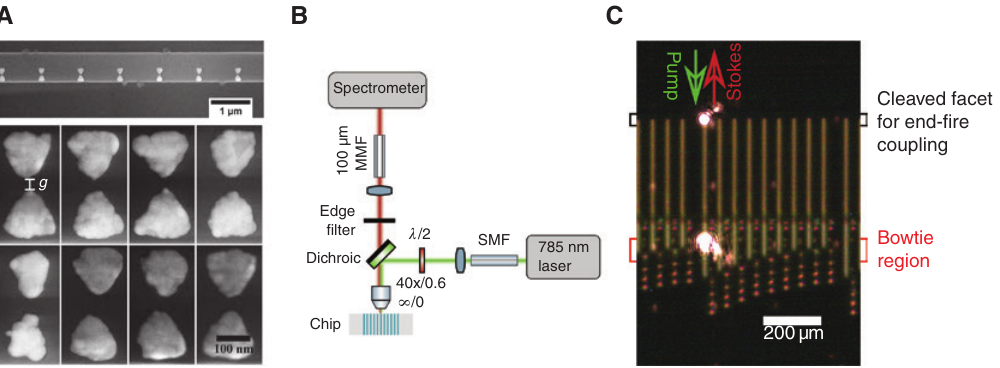
Figure 1: Waveguide geometry and optical coupling scheme. (A) Scanning electron microscopy image of an array of bowties patterned on a waveguide and close-ups of eight different bowtie antennas, with a gap g in between the two triangles of 37 ± 9 nm. (B) The chip is placed vertically under a confocal Raman microscope and end-fire coupled with a 785-nm pump laser. Stokes scattered light is collected in reflection through the same objective. (C) Camera image of the chip installed under the Raman microscope. Scattering of the pump light is visible at the entrance facet of the chip and the bowtie-patterned